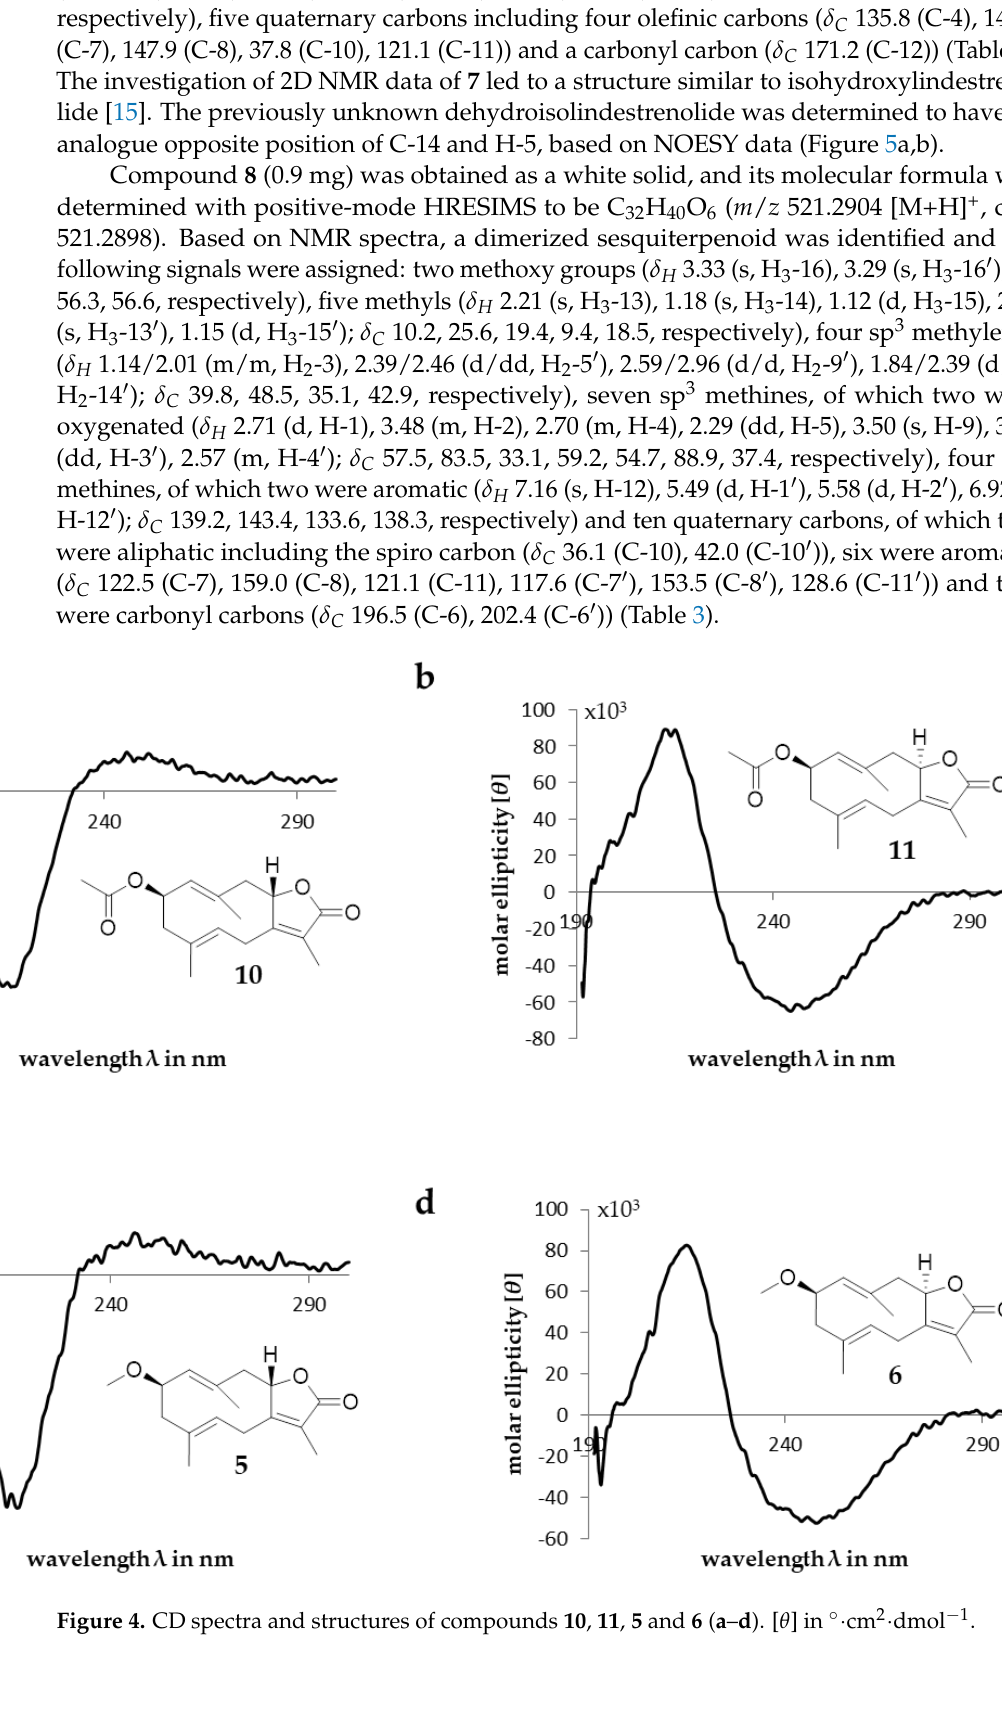
Figure 4. CD spectra and structures of compounds 10 , 11 , 5 and 6 ( a – d ). [ θ ] in °∙cm 2 ∙dmol −1 . Compound 7 (1.8 mg) with a molecular formula of C 15 H 16 O 2 , as determined with pos- itive-mode HRESIMS ( m / z 229.1228 [M+H] + , calc. 229.1223), was isolated as a colourless